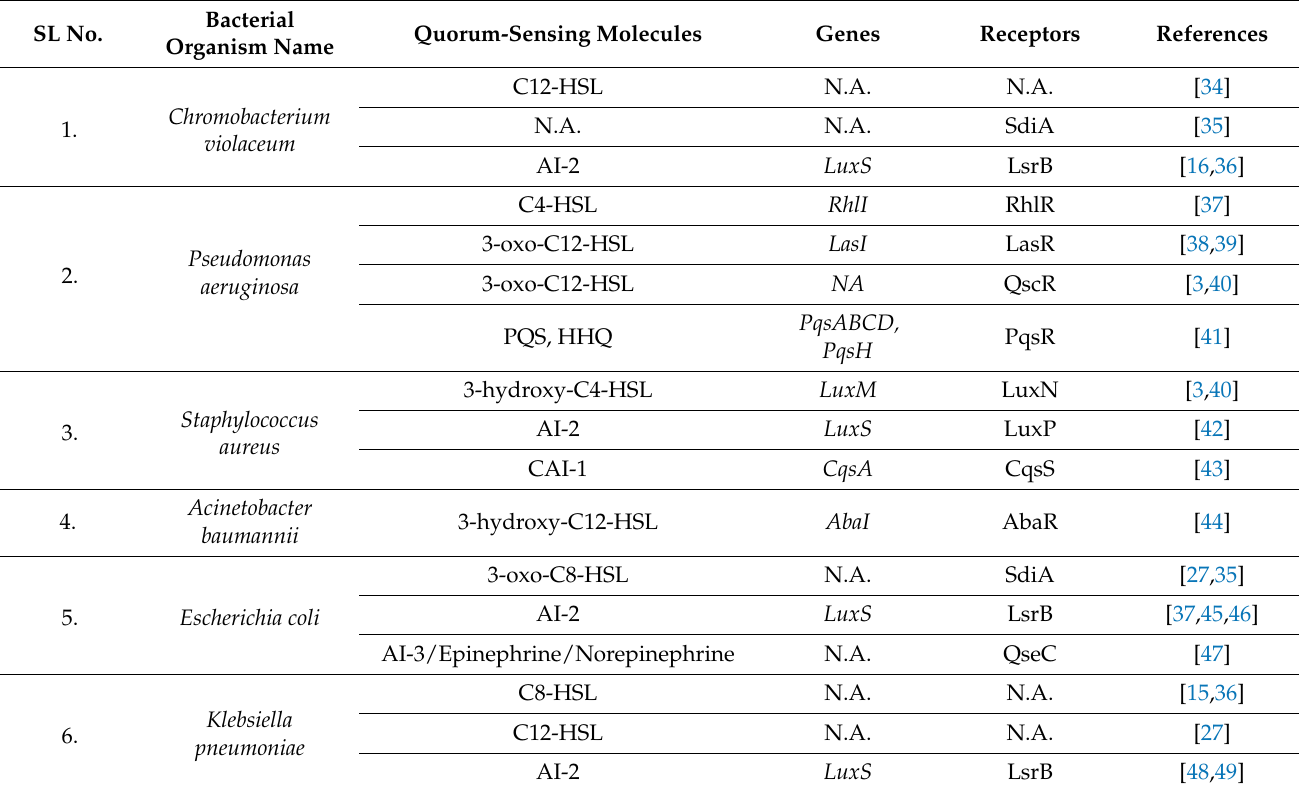
Table 1. Quorum-sensing (QS) systems of selected Gram-negative